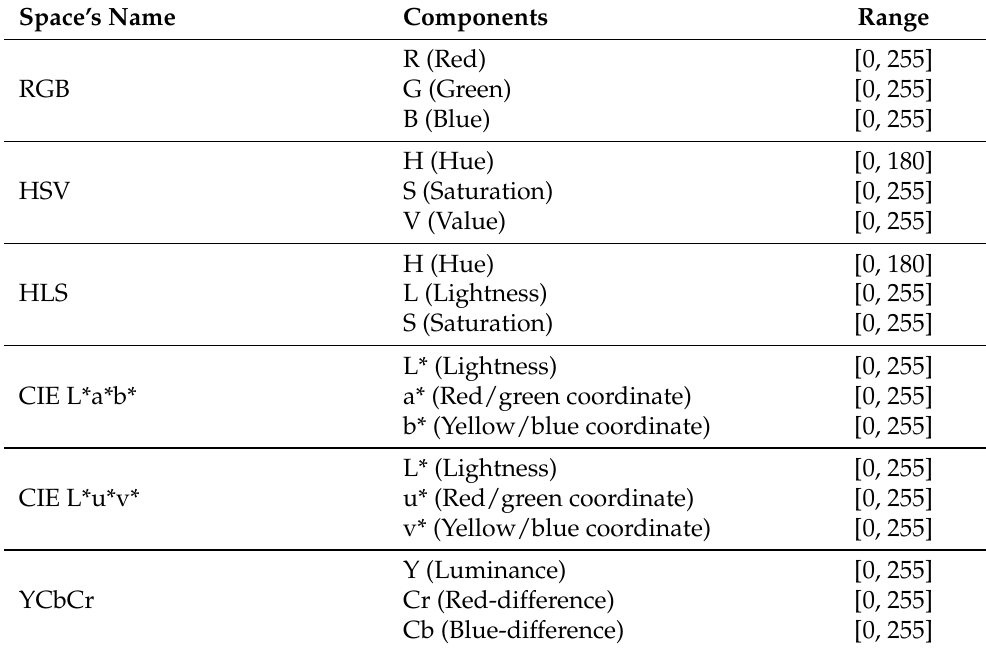
Table 1. Typical color spaces with their acronyms and range in OpenCV software for histogram